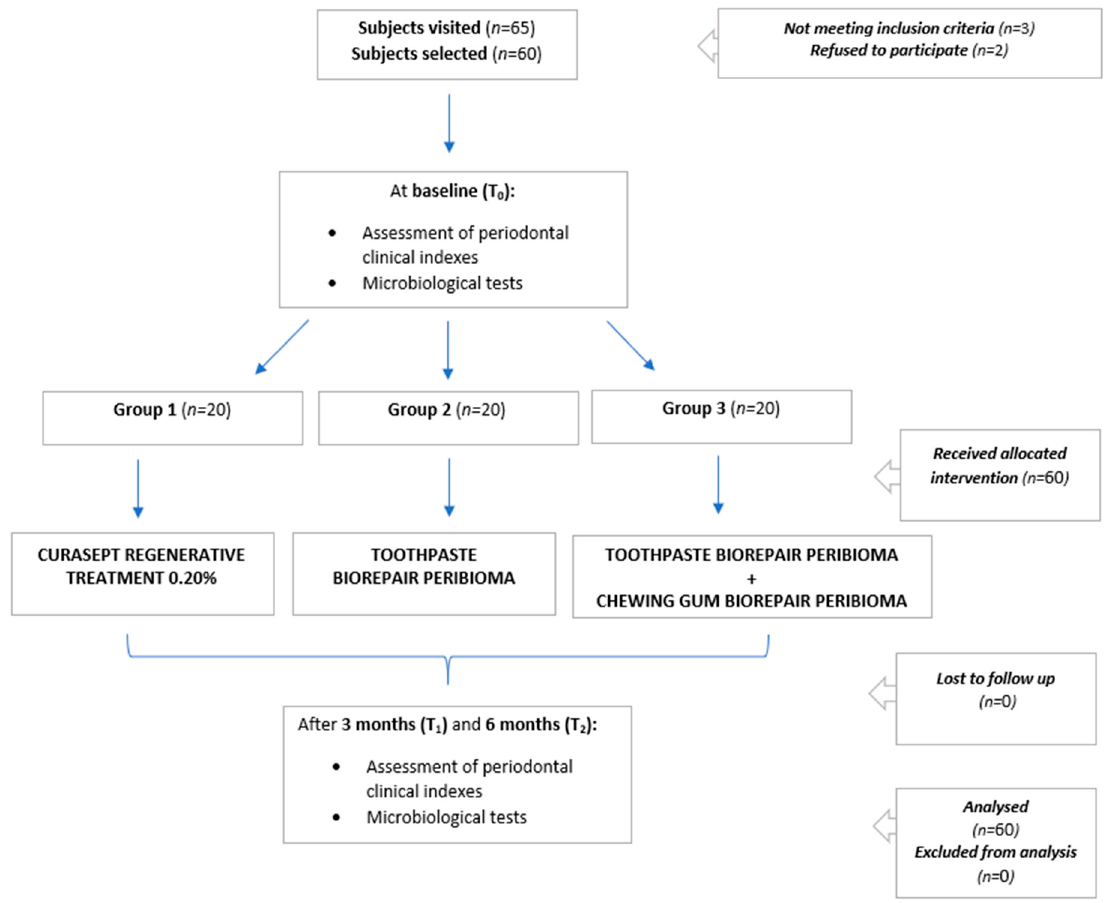
Figure 1. Flow-chart of the study.